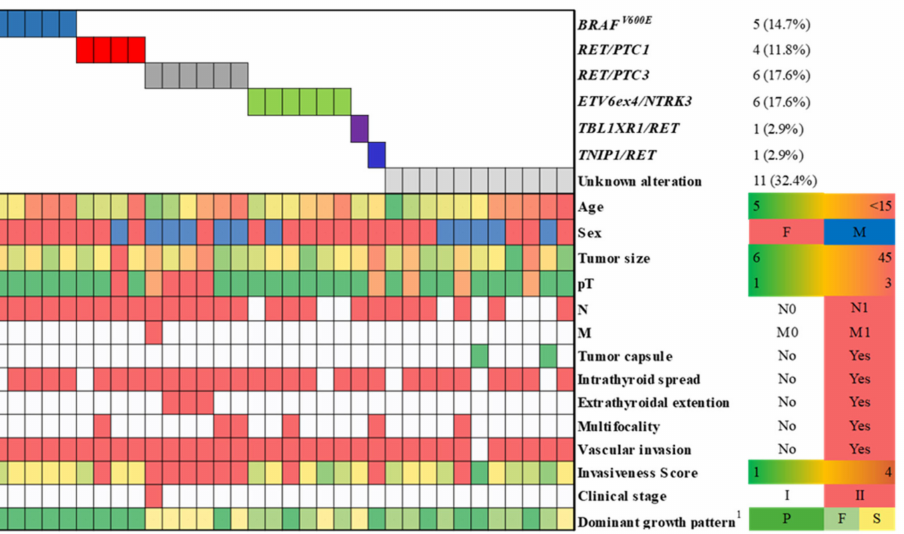
Figure 2. Distribution of driver oncogenes by clinicopathological characteristics of 34 childhood PTCs. 1 The dominant growth pattern: P—papillary, F—follicular,